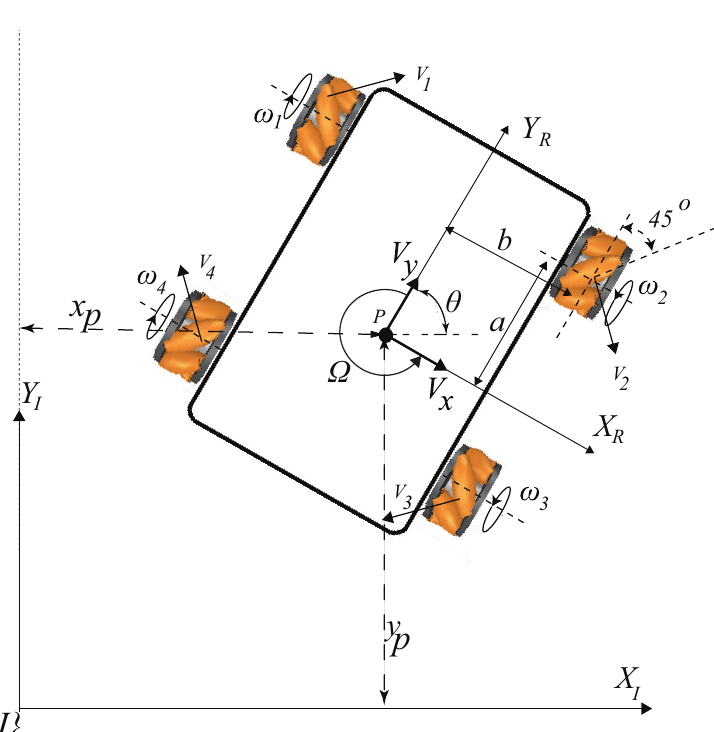
Figure 1. Kinematic representation of the Omni-direction wheels. And the global reference frame and the robot local reference